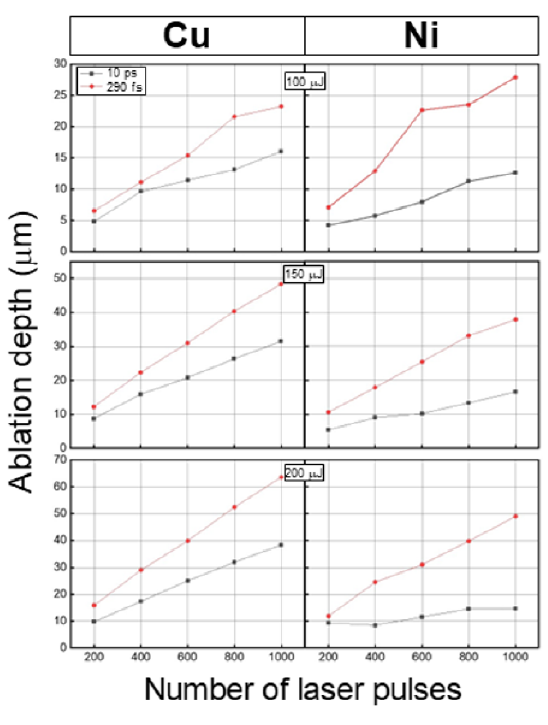
Figure 8. Variation trends of copper and nickel ablation depth under the action of ps and fs lasers.